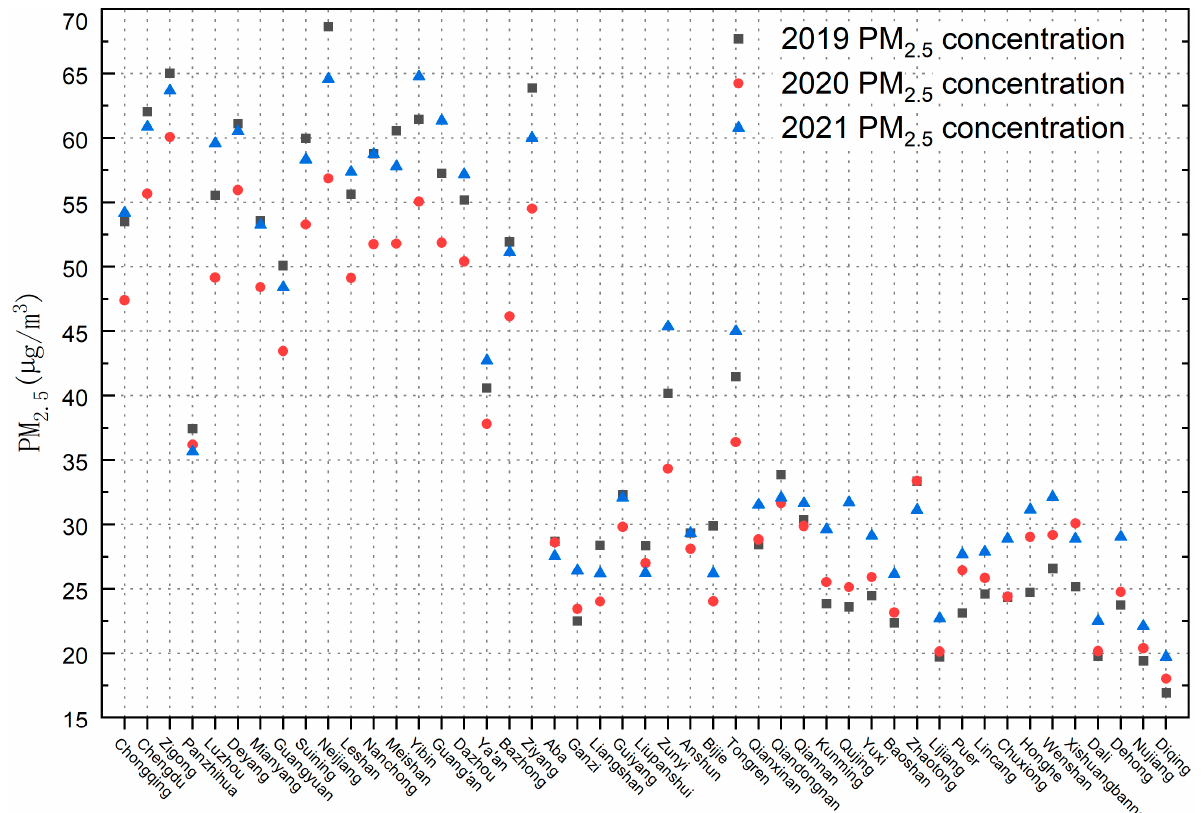
Figure 11. Changes in PM 2.5 concentrations in cities of southwest China in winter.